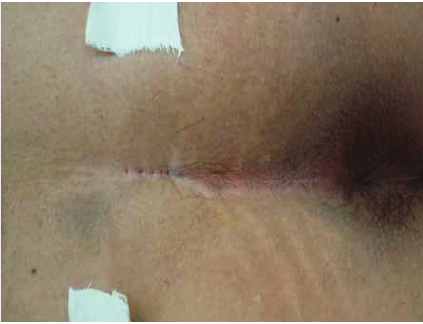
Figure 1: The complex pilonidal sinus with several openings and extended abscess.